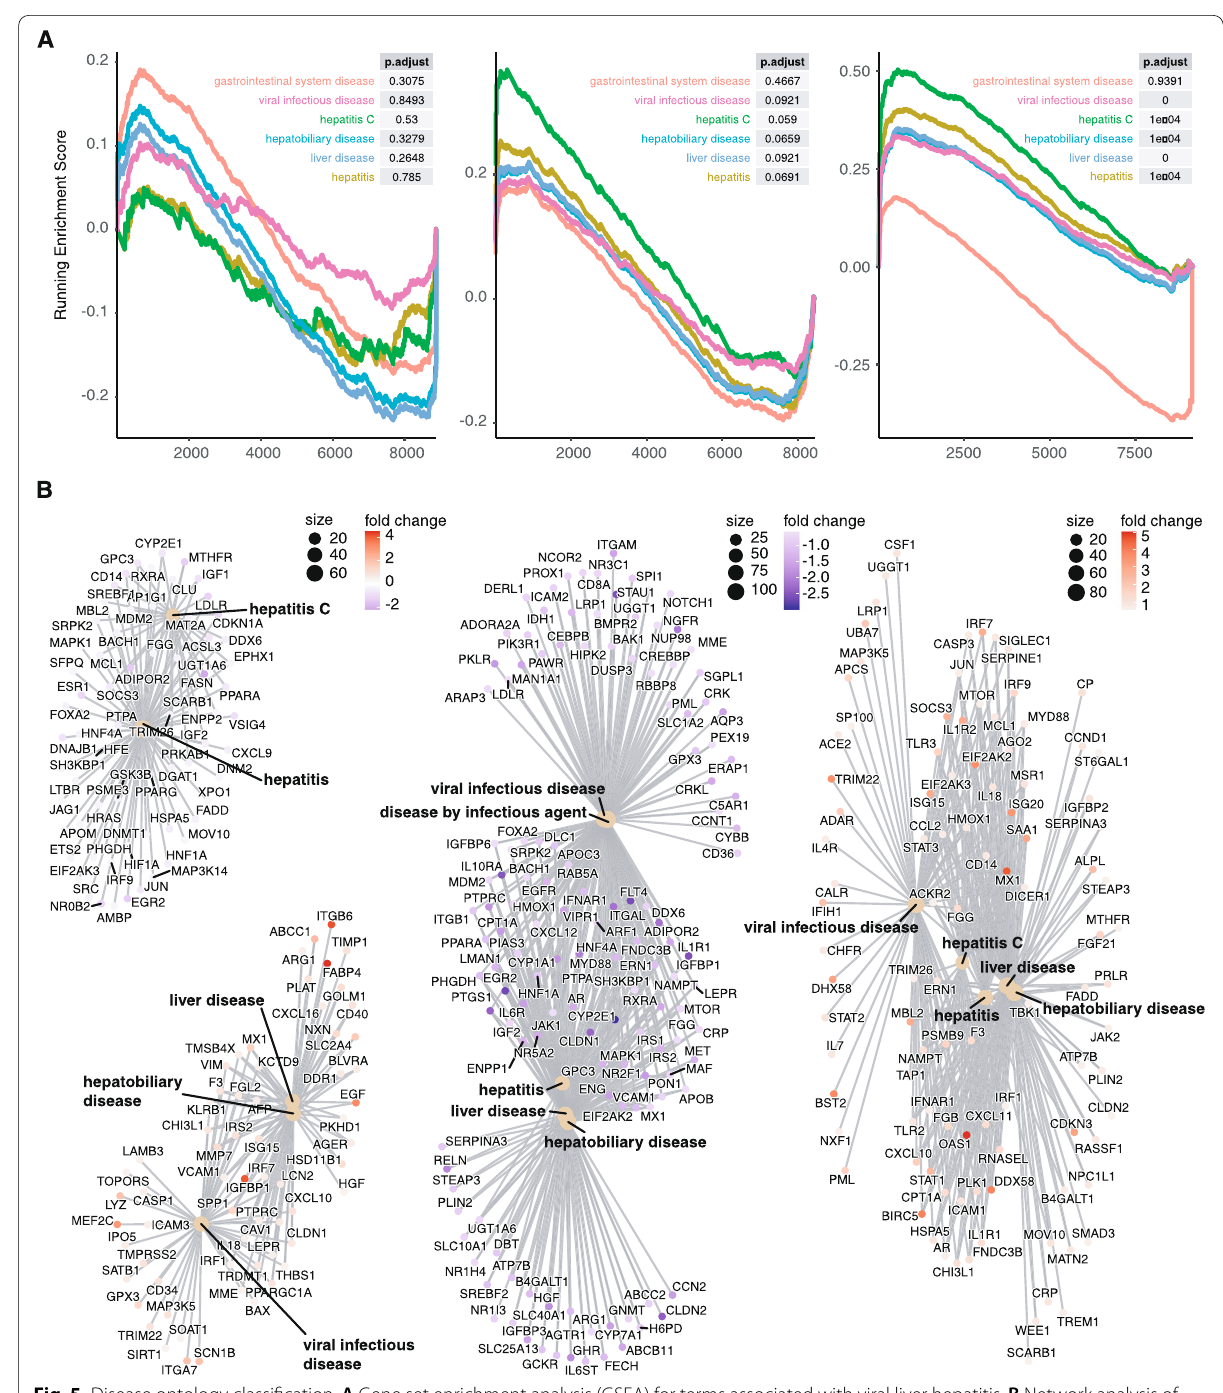
Fig. 5 Disease ontology classification. A Gene set enrichment analysis (GSEA) for terms associated with viral liver hepatitis. B Network analysis of the same terms showing the interaction between terms and involved